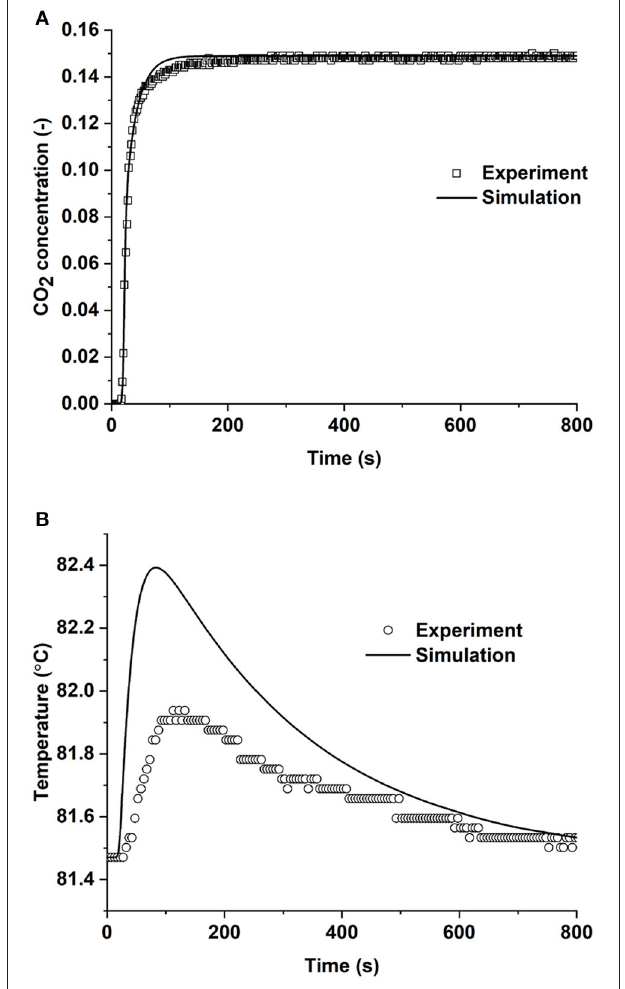
FIGURE 7 | (A) Concentration and (B) temperature breakthrough curves for 15% CO 2 -85% N 2 feed.